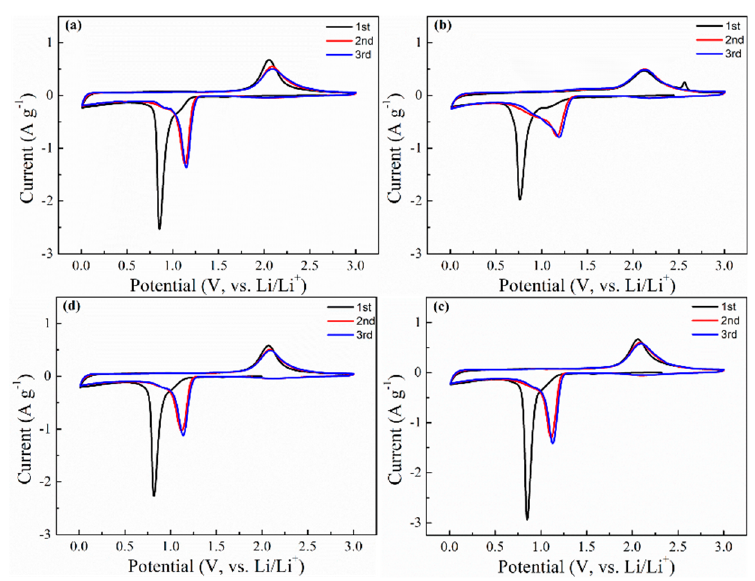
6 of 15 Table 1. The data originating from the CV curves in Figure 6. Sample